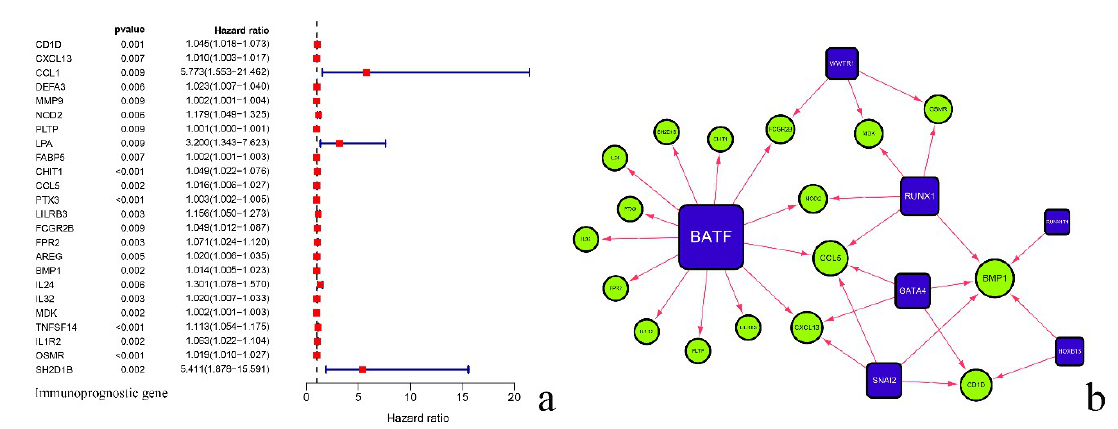
Figure 2. The 24 prognostic immune genes obtained after further screening ( a ), the construction of regulatory networks between immune transcription factors, and the prognostic immune gene ( b ). Table 1. Seven immune transcription factors screened for gene regulation. Detailed information of each transcriptome and its regulatory